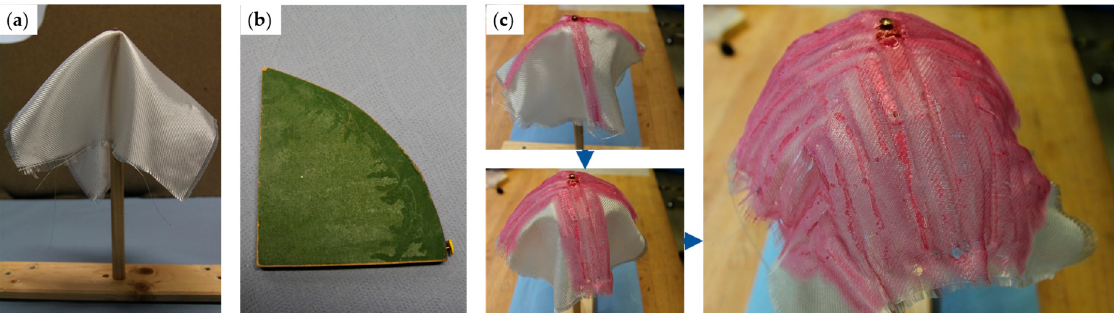
Figure 12. ( a ) Glass fiber twill weave fabric fixed on a pole; ( b ) Handheld wooden 2D quarter circle tool; ( c ) Forming sequence and result of thermoset photopolymerization using a 2D-tool [45].